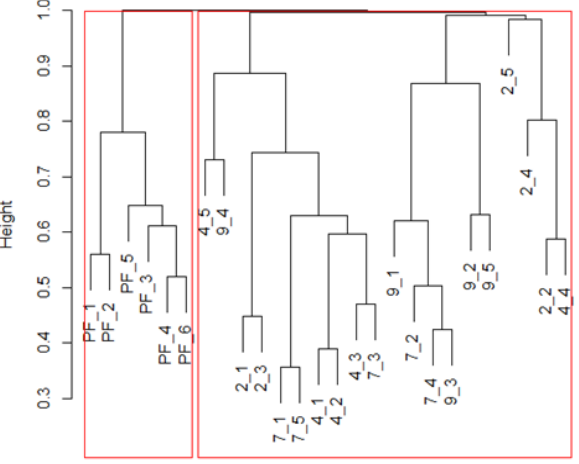
Figure 4. Grouping of plots in the primary forest (PF) and fallow forests between two- and nine-years-old in coastal areas of north Manokwari, West Papua, Indonesia. All vegetation lifeforms are grouped together and plant density in smaller plots is multiplied accordingly to give the equivalent area sampled for each lifeform. The number before the dash is the age of the fallow (2 for two-year-old, 4 for four-year-old, 7 for seven-year-old, and 9 for nine-year-old) while the number after the dash is a label for each plot.